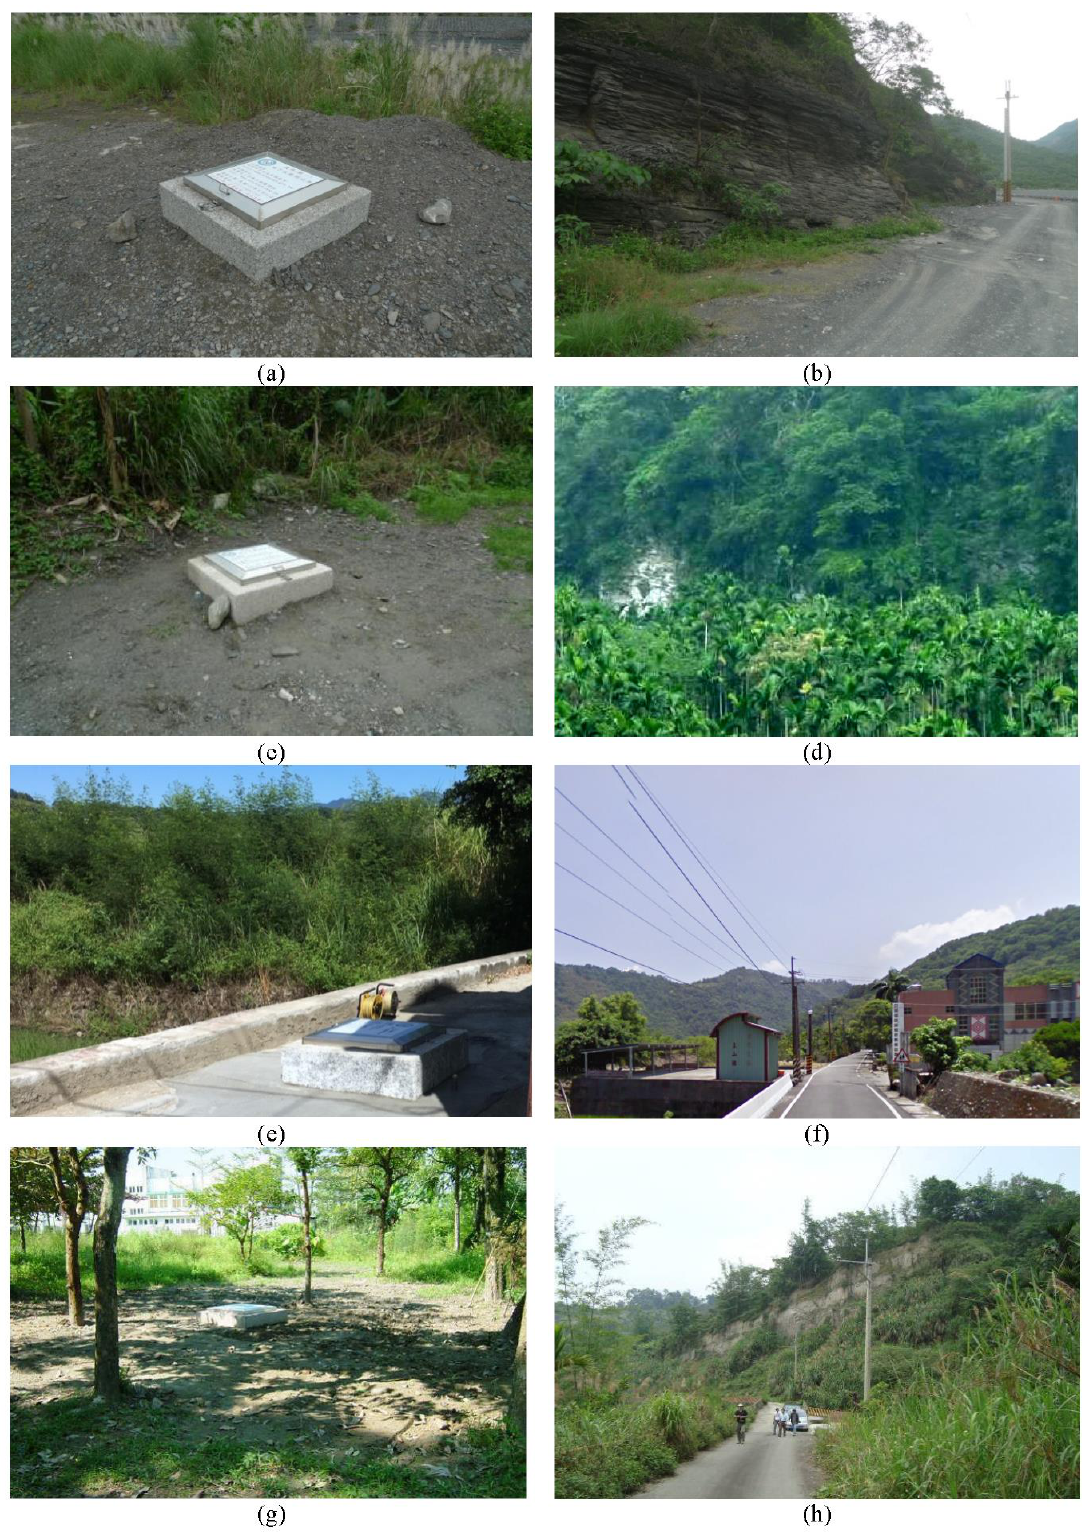
Figure 13. Photo of in-situ sites and outcrops. ( a ) B103-02 GWPS (well yield: 900 L / min); ( b ) outcrop near B103-02; ( c ) B102-08 GWPS (well yield: 780 L / min); ( d ) outcrop near B102-08; ( e ) B106-02 GWPS (well yield: 966 L / min); ( f ) terrain near B106-02; ( g ) B099-15 non-GWPS (well yield: 22.8 L / min); ( h ) outcrop near B099-15.